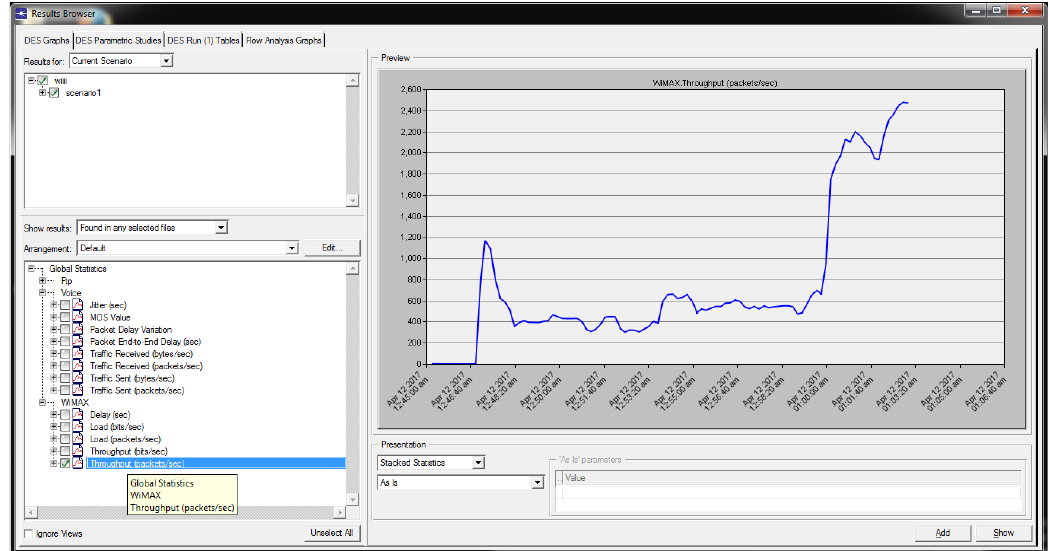
Fig. 2. Global Statistics WiMax throughput packet/second for overall network, reaches 2600 (2.6kbps) packet per second approximately.